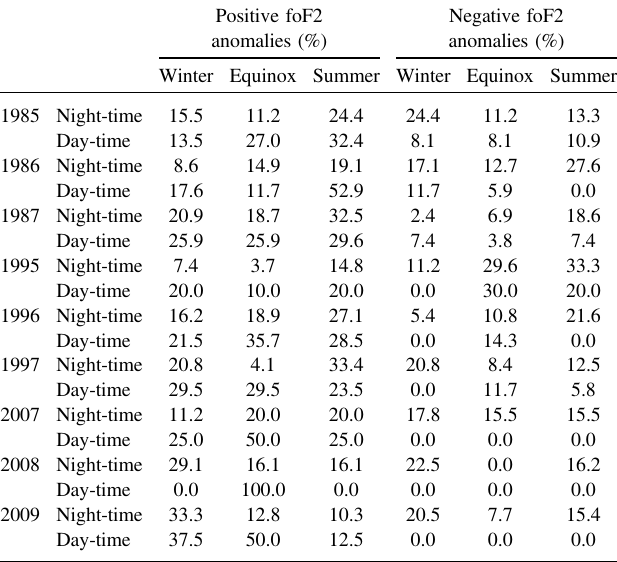
Table 2. Percentages of positive and negative foF2 anomalies, with a minimum duration of 3 h, observed by the Rome ionospheric station, computed over the total number of foF2 anomalies observed during night-time hours and day-time hours respectively.